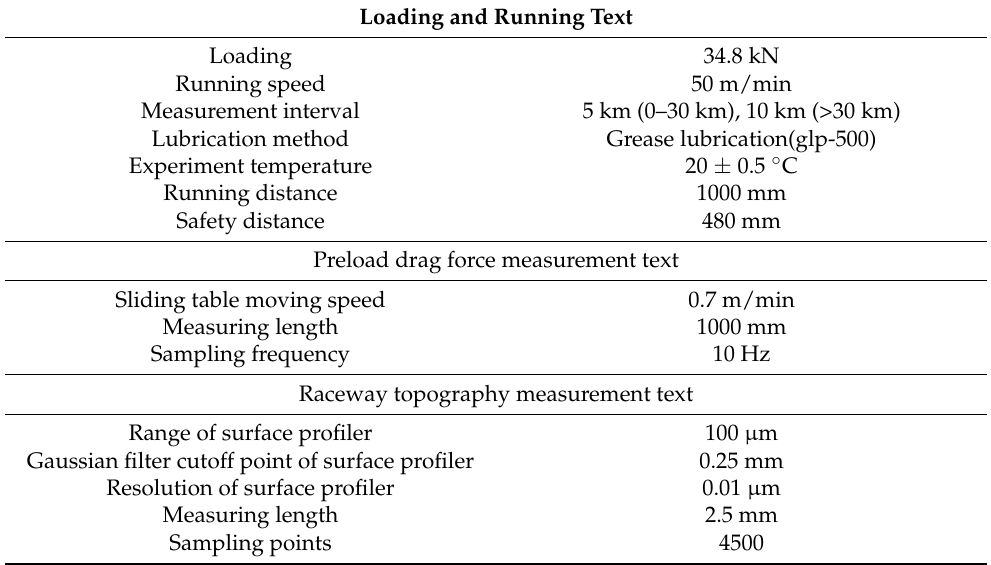
Table 2. Experimental